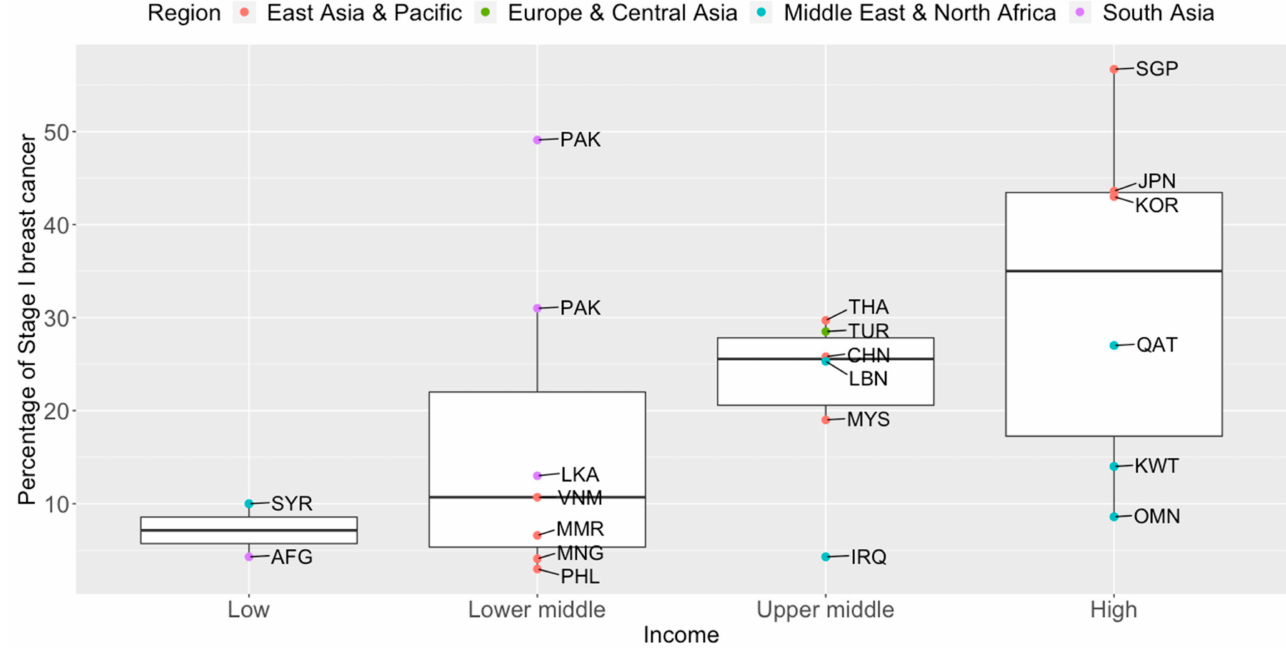
Figure 2. Box plots of early-stage breast cancers diagnosed (Stage I only) by income groups and regions in Asia. Source of income level data: World Development Index, 2020. AFG: